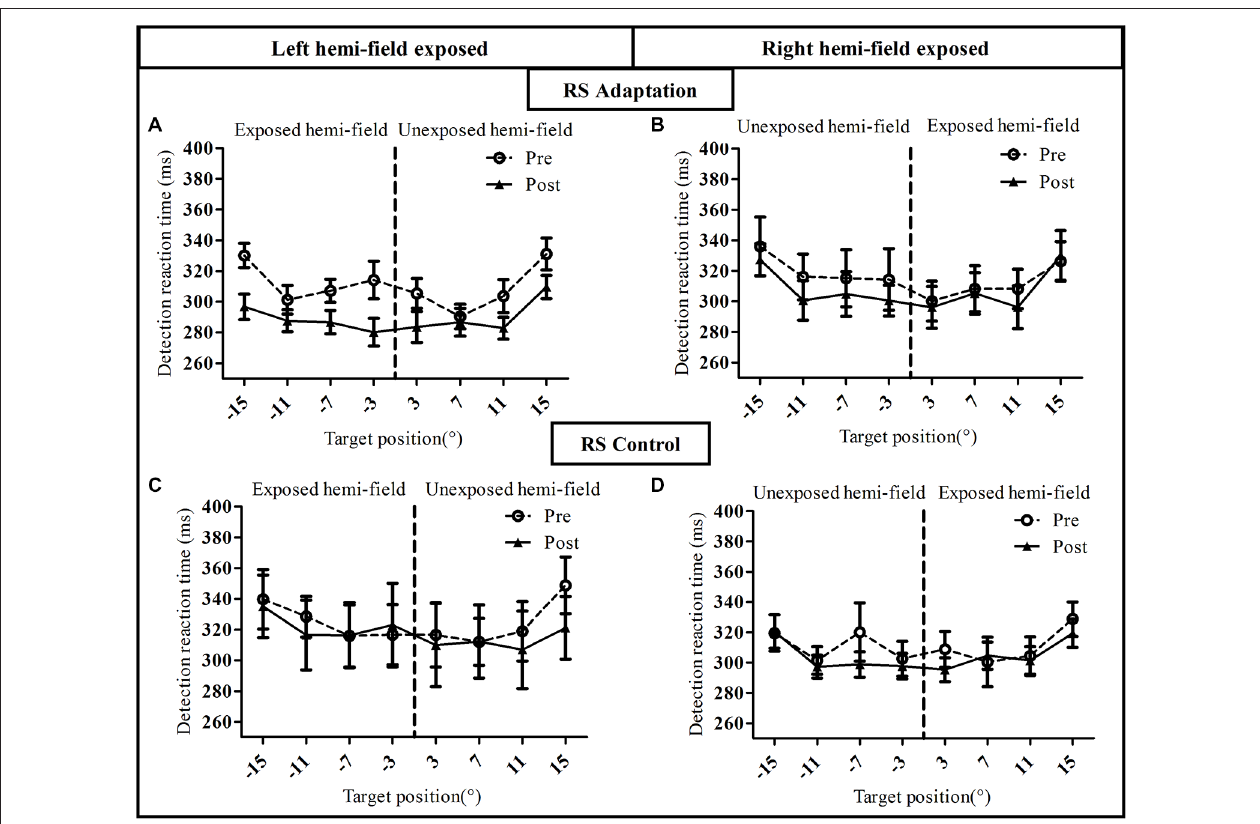
post-exposure phase (filled triangles, solid line). Upper row: adaptation groups ( A : Adapt-Left, B : Adapt-Right group), lower row: control groups ( C : Control-left group, D : Control-right